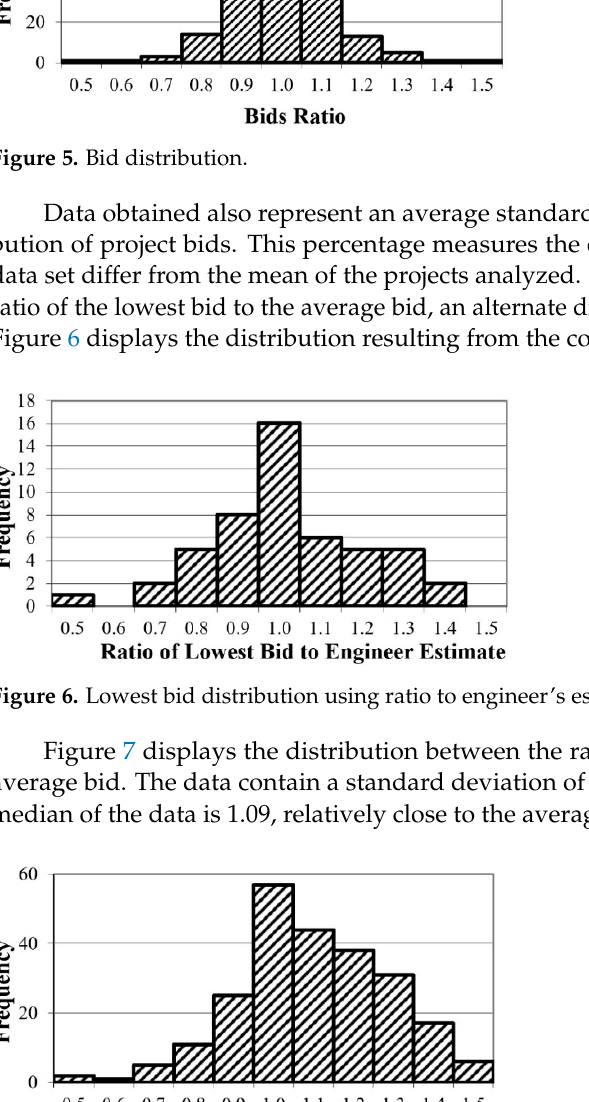
Figure 8. Distribution of lowest bid using ratio to average bid. Comparison between Figures 7 and 8 indicate skewness values in two opposite directions, which are essential for understanding the bidding behavior. The skewness of ratio of bids to engineer’s estimate clearly indicate the under-estimation of the engineer’s estimate for determining the bid value. This skewness might be a function of different parameters, including but not limited to market characteristics at the time of bidding interacting type and scope of projects within a small portfolio or large program. For instance, the wide spread of projects in this study in respect to scope and bidding period has changed the direction of skewness in comparison with the work presented by Tehrani (2016). In another observation, the opposite direction of skewness in Figure 8 represents the competitiveness behavior of bidders aiming to provide the lowest bid disregarding the engineer’s estimate. 5. Conclusions Analyzing cost estimates of similar projects within the same geographical district allows for a better understanding of the gap existing between the engineer estimate and the final project cost upon completion of construction. Statistical analysis of the resulting bids denotes the distribution (Figure 4) relating the average of bids to be an appropriate model for analysis of bids. When determining a mechanism for the estimation of sample project cost, analysis regarding the data obtained allowed for three approaches to be placed in order, as shown in Table 1 following studied literature. Shown through the error values within the Table,